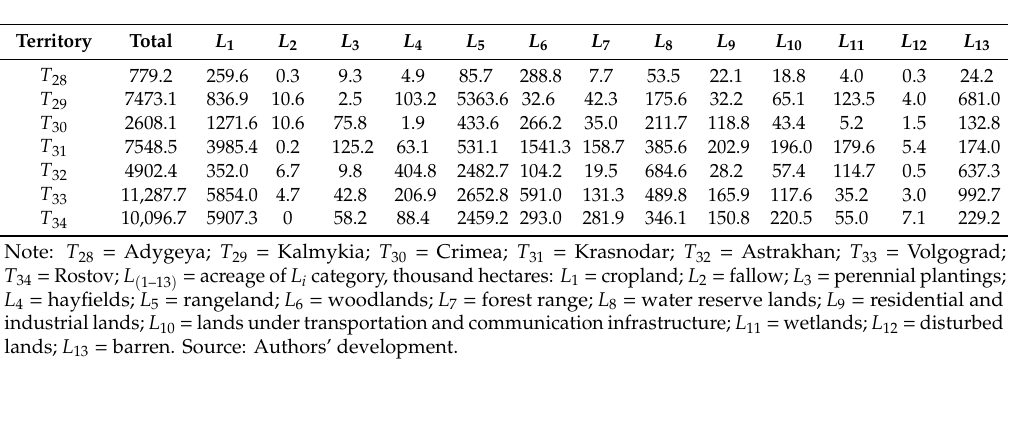
Table A3. Land acreage data of the Southern Federal District in thousand hectares. Mean values for